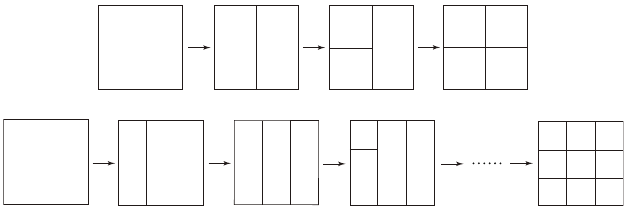
Figure 3. Illustration of the resolution transform using the partitioning rule. The upper panel shows an example of the resolution transform from levels 1 to 4, and the lower panel shows the transform from levels 1 to